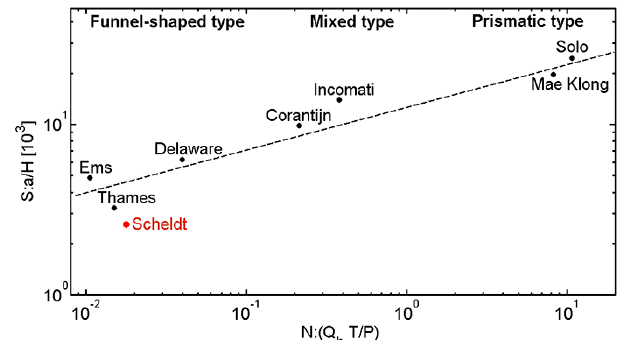
Figure 1. Relationship between geometric ( S ) and hydrodynamic ( N ) characteristics of alluvial estuaries (modified from Savenije, 1992). The Scheldt estuary, where C-GEM has been tested, is high- lighted in red.